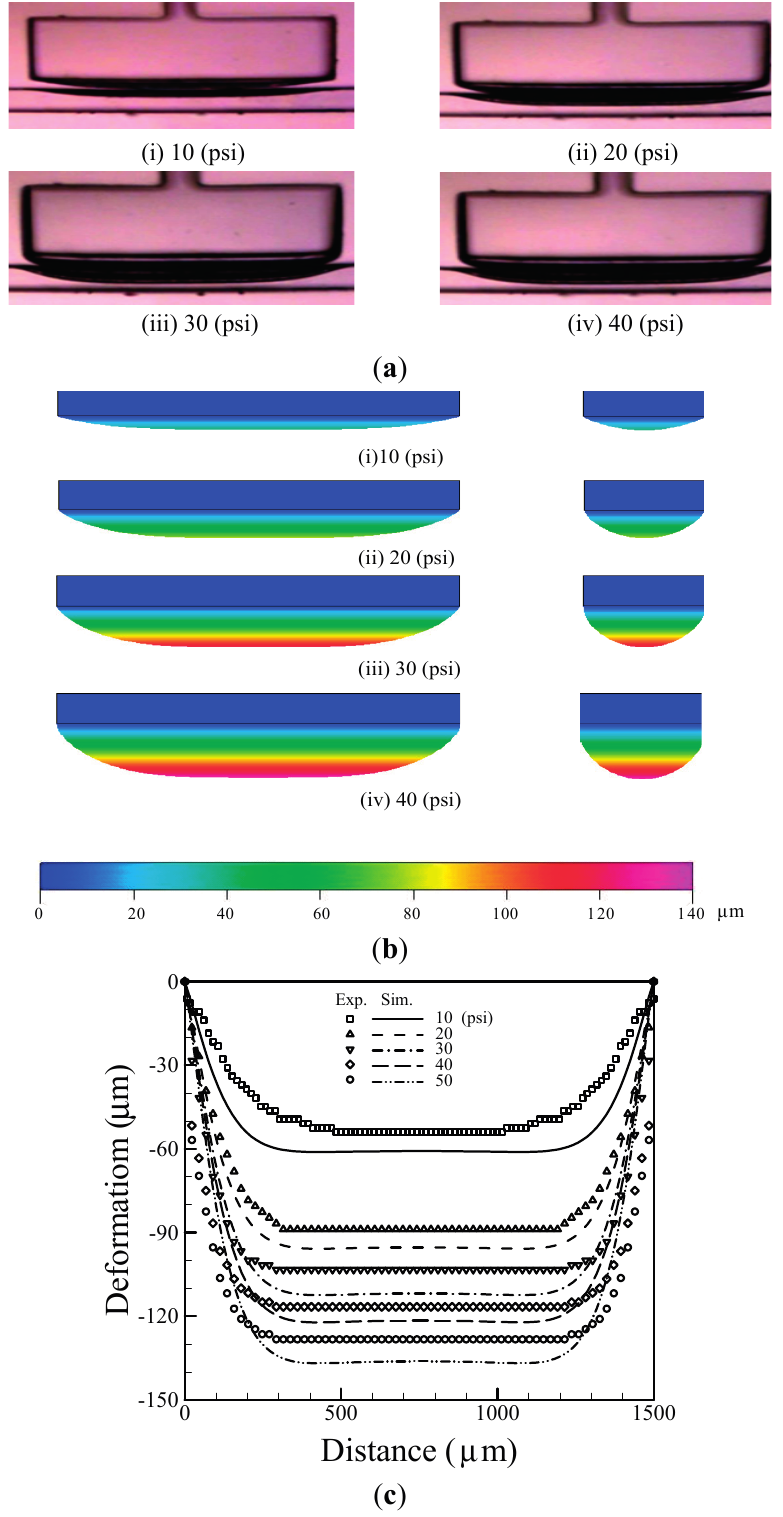
Figure 5. ( a ) Experimental and ( b ) numerical deformation of the flexible membrane structure ( c ) comparison of numerical calculations and experimental measurements at various air